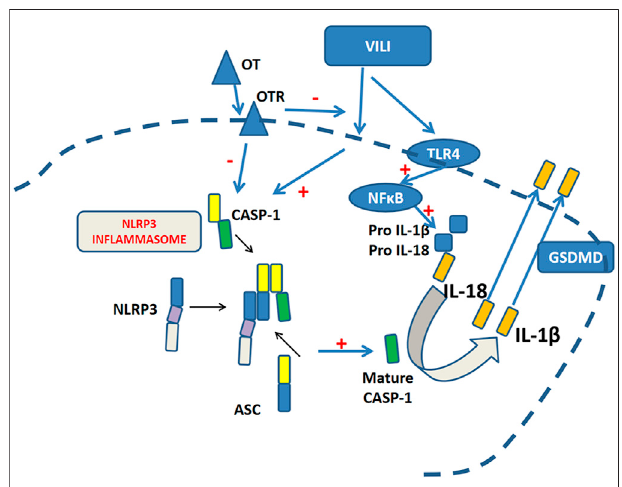
FIGURE 1 | Oxytocin protects against ventilation-induced lung injury through NLRP3- mediated in fl ammatory